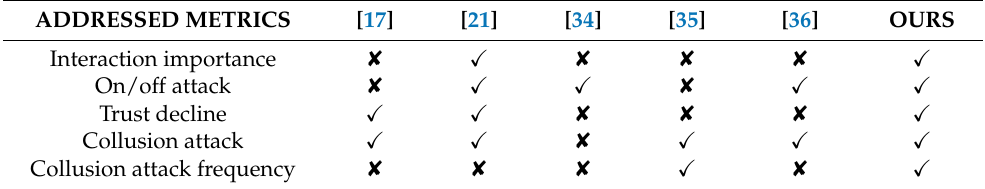
Table 2. Comparison of security and